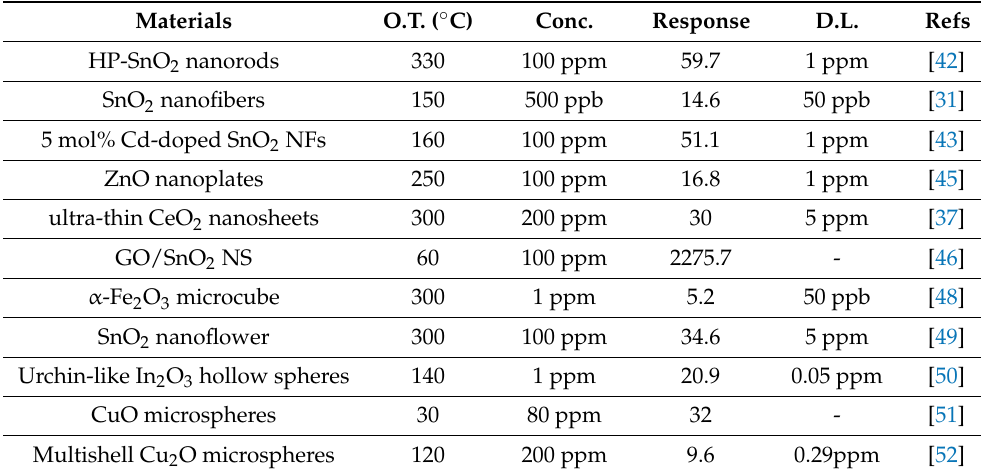
Table 1. Formaldehyde sensing properties of different gas-sensing materials.